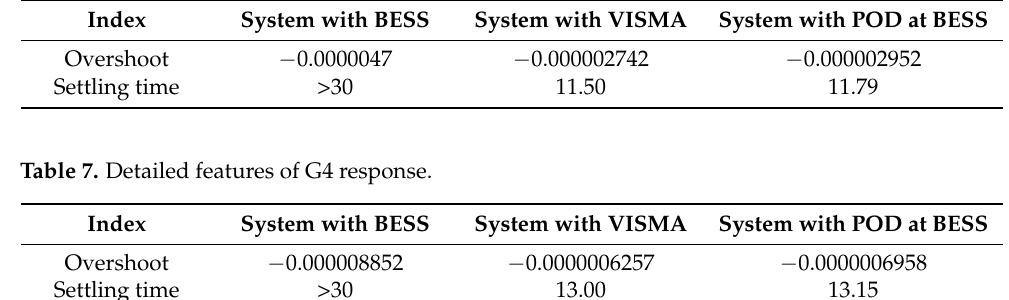
Table 6. Detailed features of G3 response.